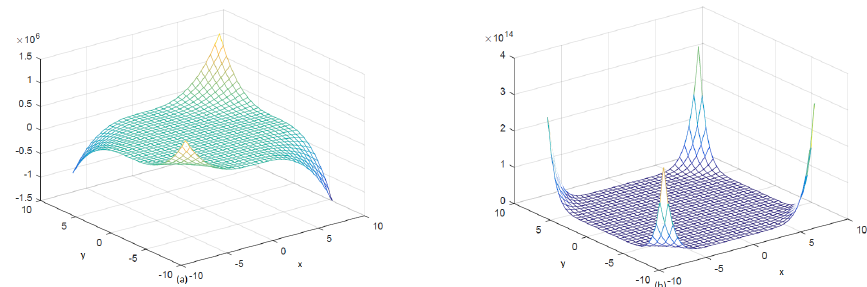
Figure 6: Plotting of (a) M-polynomial and (b) NM-polynomial of caulibugulone